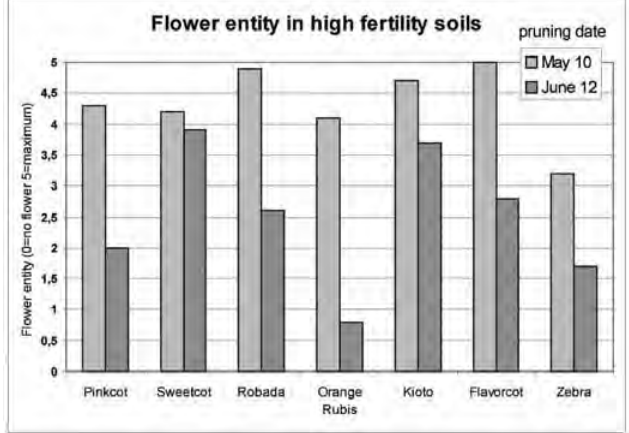
Fig. 4 - Flowering estimated entity in 8 varieties in response to pruning applied in May (early pruning), or in June.